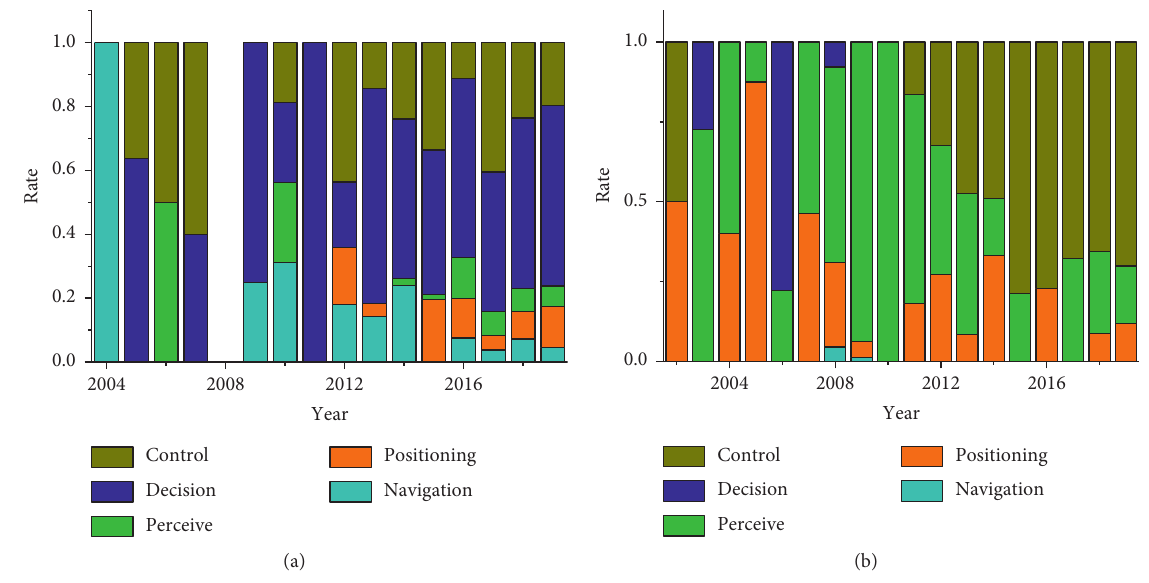
Figure 12: Comparison between (a) papers and (b)